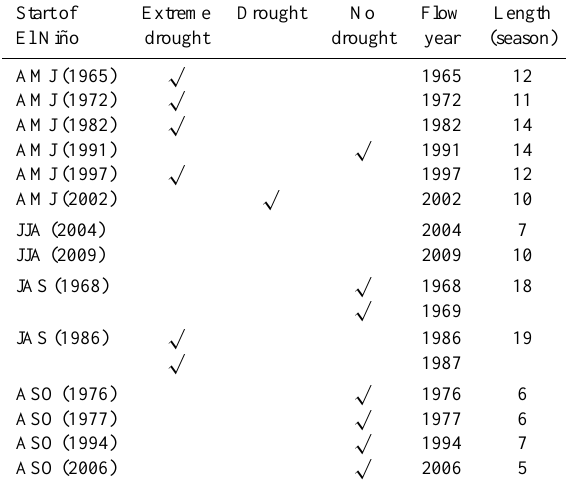
Table 2. The effect of the start date of El Niño on the drought of the upper catchment of the Blue Nile during JJAS of the same year.